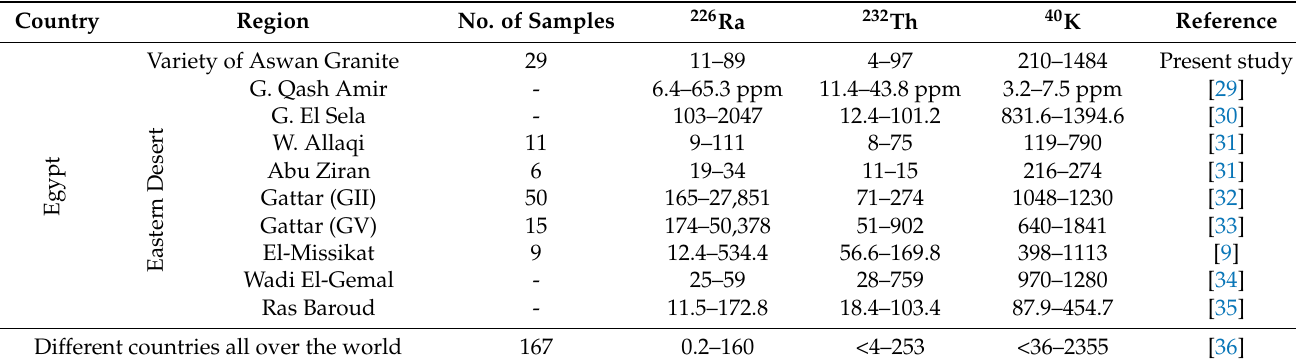
Table 2. Comparison of activity concentrations of the natural radionuclides ( 226 Ra, 232 Th and 40 K) (Bq kg − 1 ) in granite samples of the present study with those obtained in other published data.